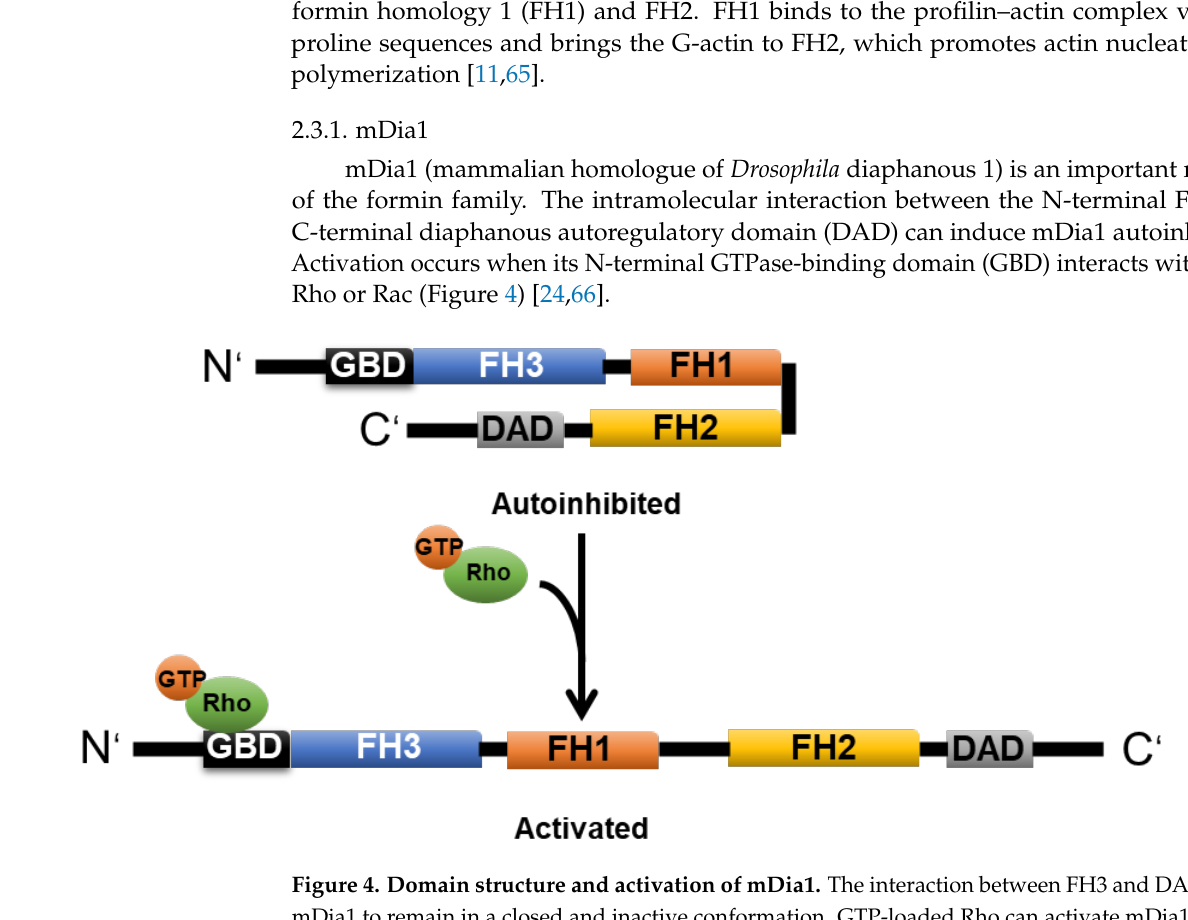
Figure 4. Domain structure and activation of mDia1. The interaction between FH3 and DAD causes mDia1 to remain in a closed and inactive conformation. GTP-loaded Rho can activate mDia1 through binding to the N-terminal GBD, which causes mDia1 to adopt an open and active form. The illustrated molecules are not drawn to scale.